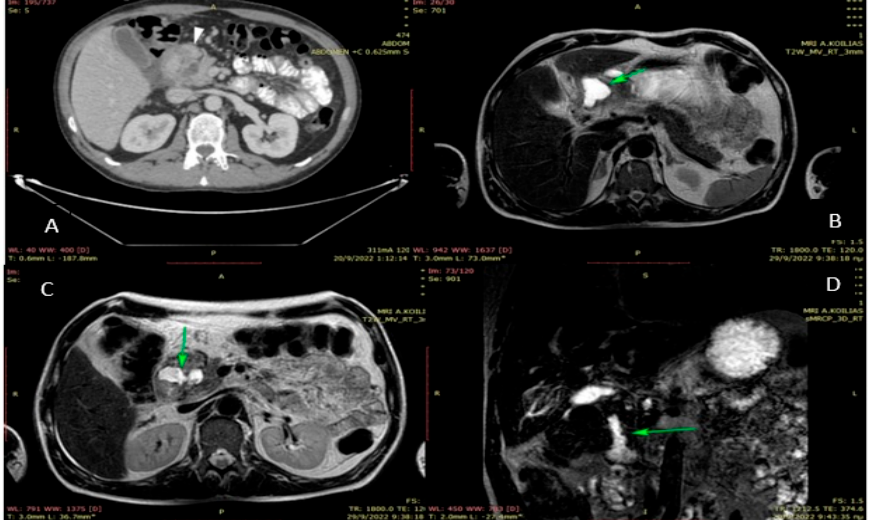
Figure 2. MRI findings. ( A ): Same CT: Tissue to gastric antrum that hances exactly the same as the rest of the pancreas(arrowhead)-ectopic pancreatic tissue Fat stranding and small fluid collection. ( B ): Encapsulated subhepatic fluid collection. ( C ): Cystic lesions to the duodenal wall with proteinic content. Edema to the duodental wall and pancreatic head. ( D ): MRCP: Stenosis of the descending duodenum.